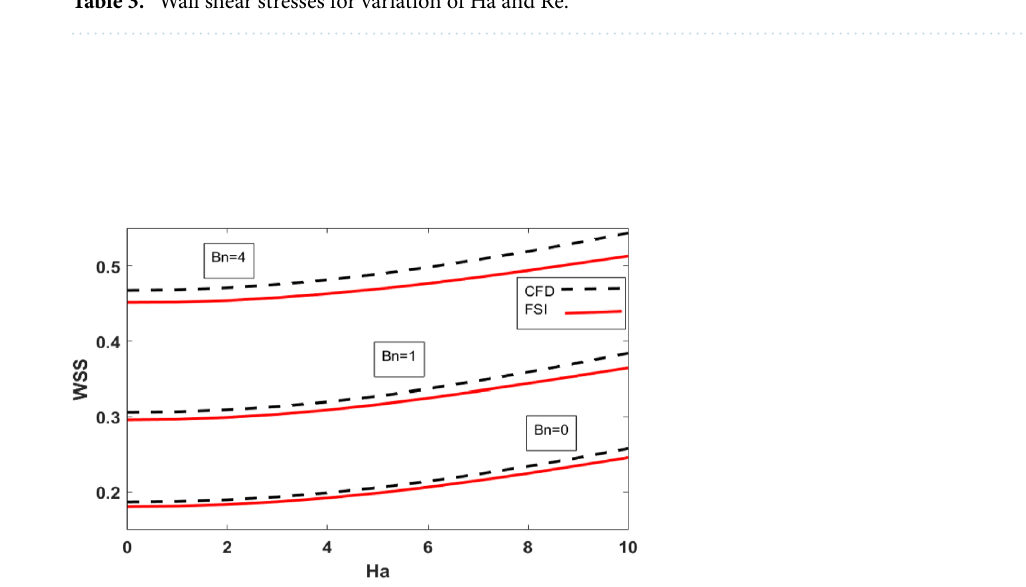
Table 3. Wall shear stresses for variation of Ha and Re.